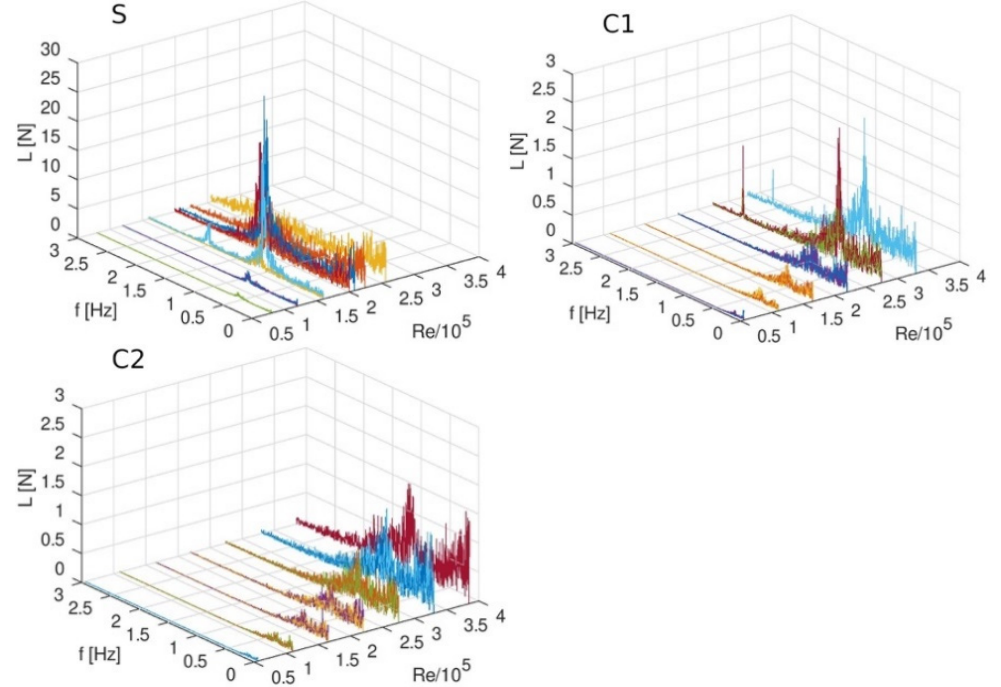
Figure 10. Lift forces Fourier transform as function of the Reynolds number for the three test cases: S , C1 and C2 .